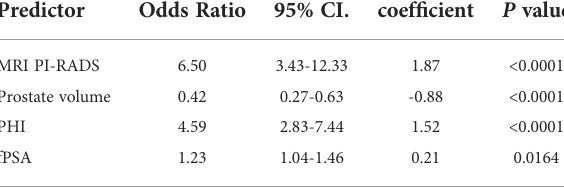
TABLE 3 Multivariate logistic regression analysis of predictors in the prediction of csPCa. Predictor Odds Ratio 95% CI.